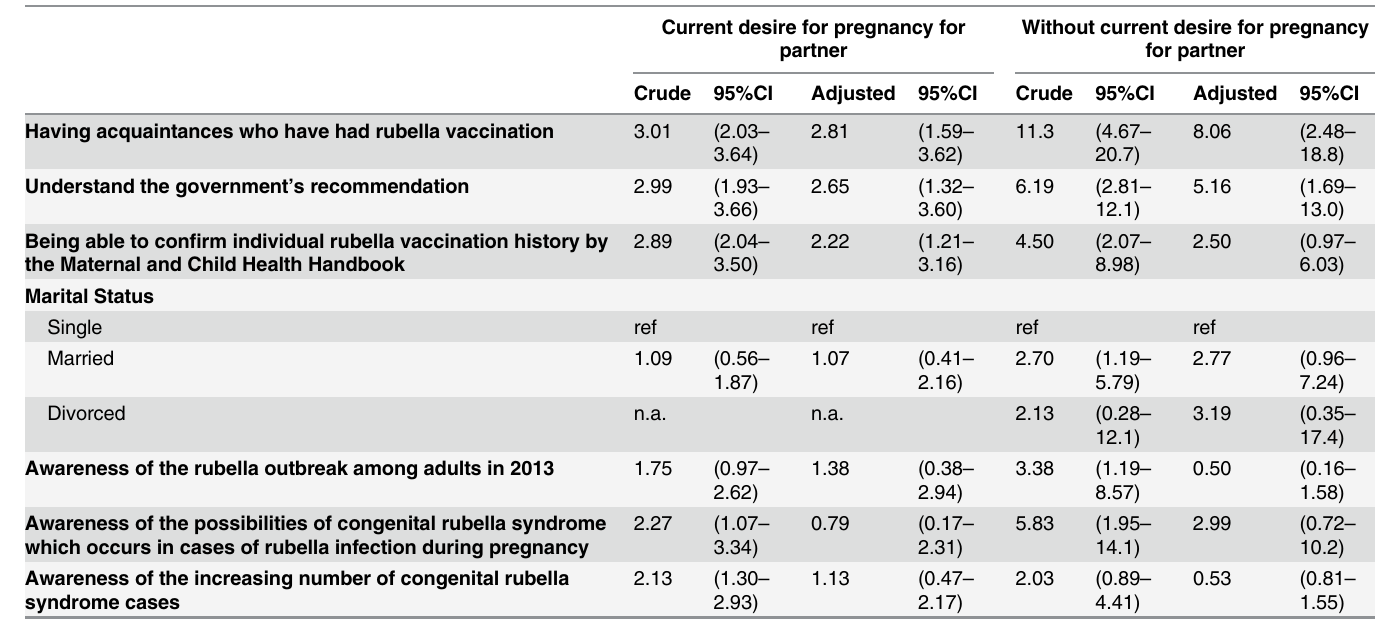
Table 6. Statistical associations between vaccination or antibody testing for rubella in 2013 and current desire for pregnancy for partner for men.